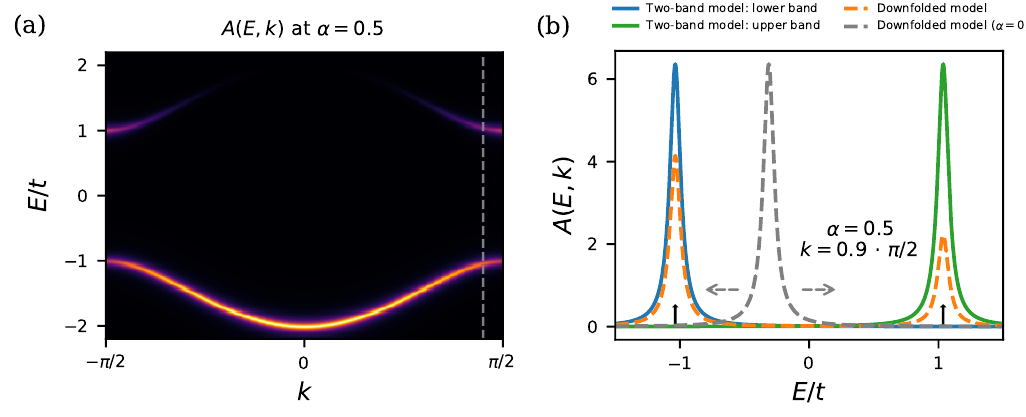
Figure 5: Spectral function of the downfolded single-band model for α = 0.5. Here, a broad- ening η = 0.05 is used to improve visibility. (a) Spectral-weight transfer to the upper band occurs due to the self-energy. See Fig. 1b for the dispersion in the original two-band model. π (b) Cross-section at k = 0.9 · , indicated by the grey dashed line in (a). The original model has 2 two bands with spectral weight at E = ±| (cid:34) ( k ) | , respectively (small vertical bars). In the single- band model at α > 0, the self-energy leads to some spectral-weight transfer to the position of the upper